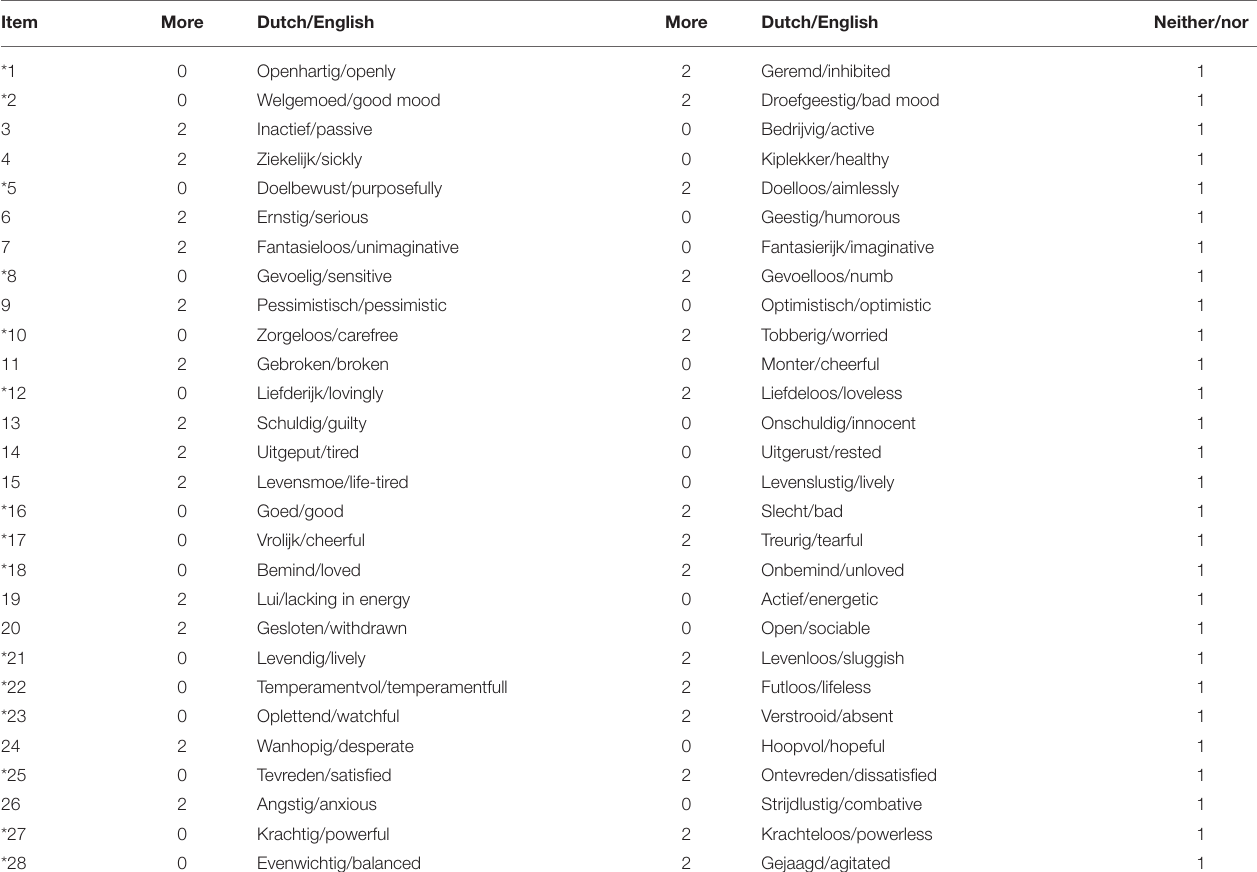
TABLE 2 | Items of the Adjective Mood Scale (AMS) and their assigned labels.